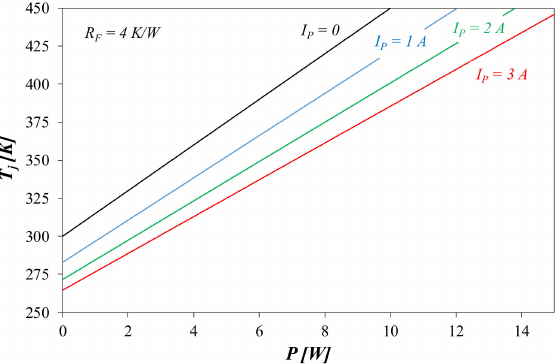
Figure 8. Device junction temperature versus power dissipated at selected values of the current I p .